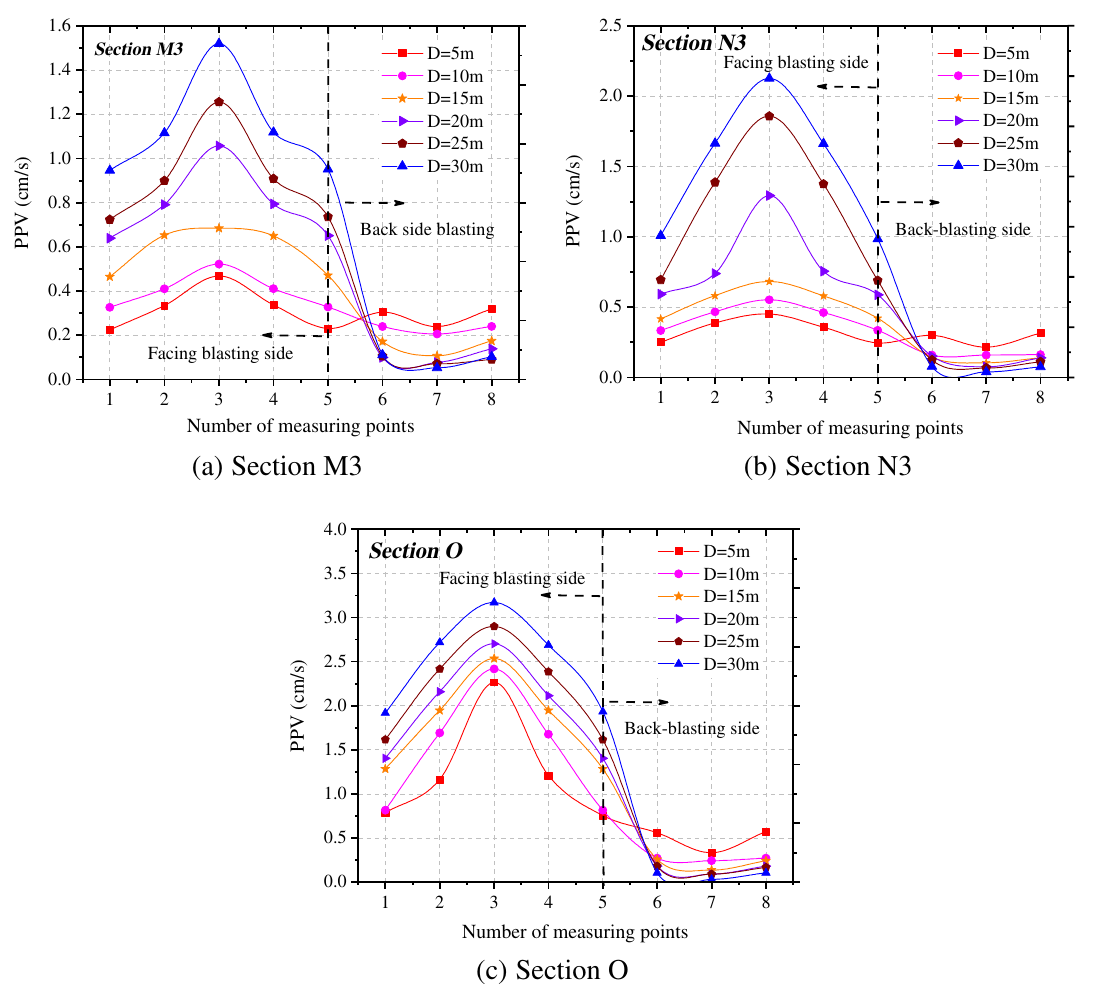
Figure 12. PPV distribution in surrounding rock of adjacent tunnel under different tunnel spans.